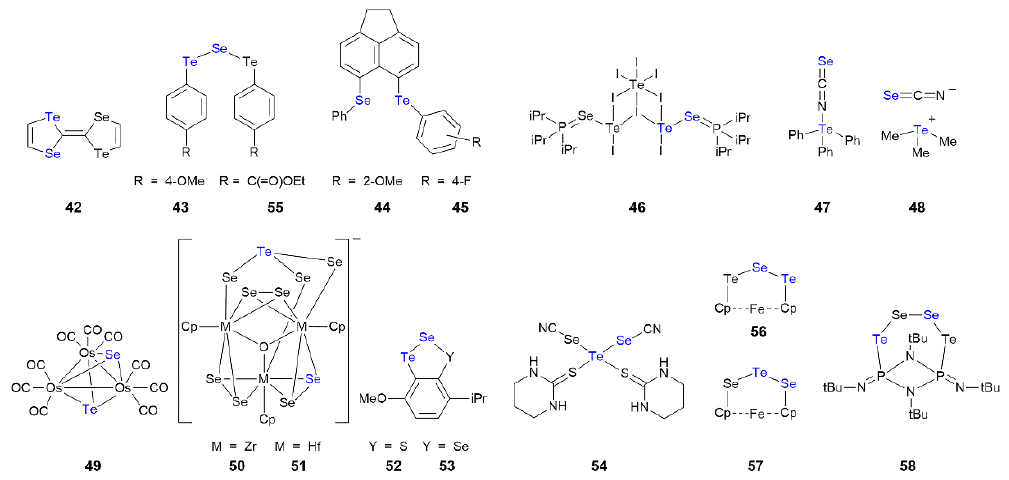
Figure 12. Chemical diagrams for tellurium compounds 42 – 58 ; Cp is cyclopentadienyl.